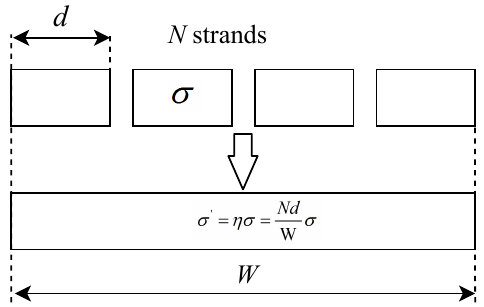
Figure 3. Equivalent model of multi-strands conductor.